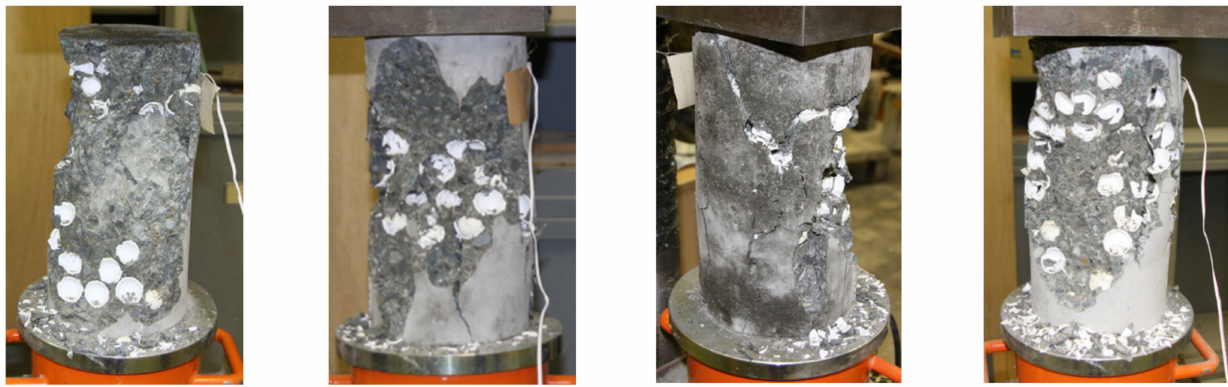
Figure 21. The failure picture of 2009 CS concrete.